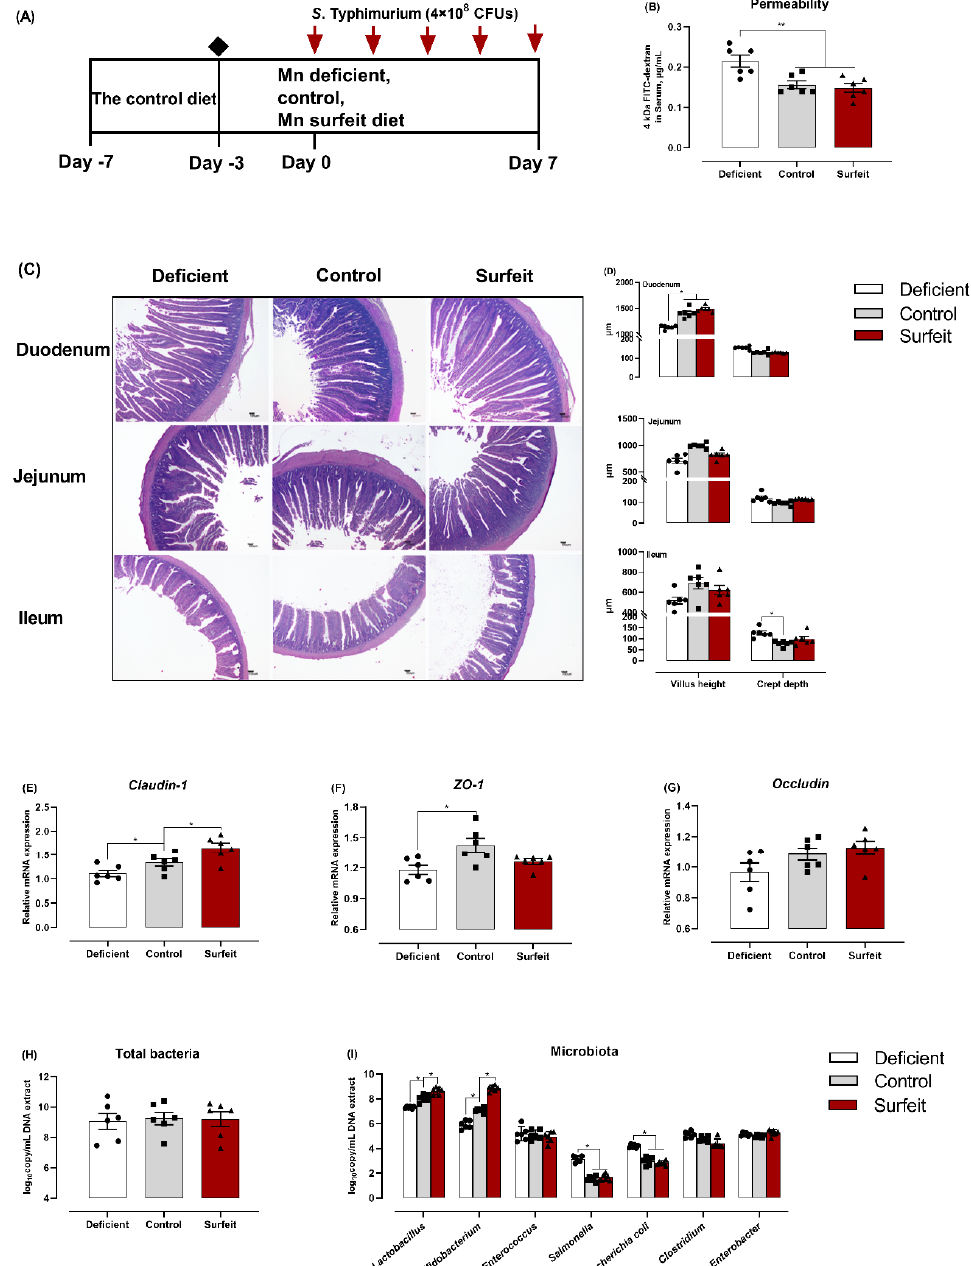
Figure 2. Dietary Mn supplementation improves intestinal barrier and intestinal microbiota of birds infected with S . Typhimurium. ( A ) Schematic presentation of dietary Mn treatments. One-day-old broilers were co-housed and fed the control diet (the basal diet plus additional 40 mg / kg Mn) for 4 days and then fed with either the Mn-deficient, the control, or the Mn-surfeit diets (the basal diet plus additional 0, 40, or 100 mg Mn / kg, respectively), for a further 10 days. All birds were orally inoculated with 4 × 10 8 CFUs of S . Typhimurium at 7 days-of-age. ( B ) The permeability was evaluated by fluorescein isothiocyanate (FITC)-dextran. ( C ) Representative hematoxylin/eosin (H&E) staining and ( D ) villus height and crypt depth were measured. Scale bar = 100 μ m. ( E − G ) RT-PCR quantification of claudin-1, zonula occludens-1 (ZO-1), and occludin in jejunal mucosa. ( H ) and ( I ) The composition of the microbiota from the digesta of jejuna. Data represent means with standard deviation. * p < 0.05; ** p <